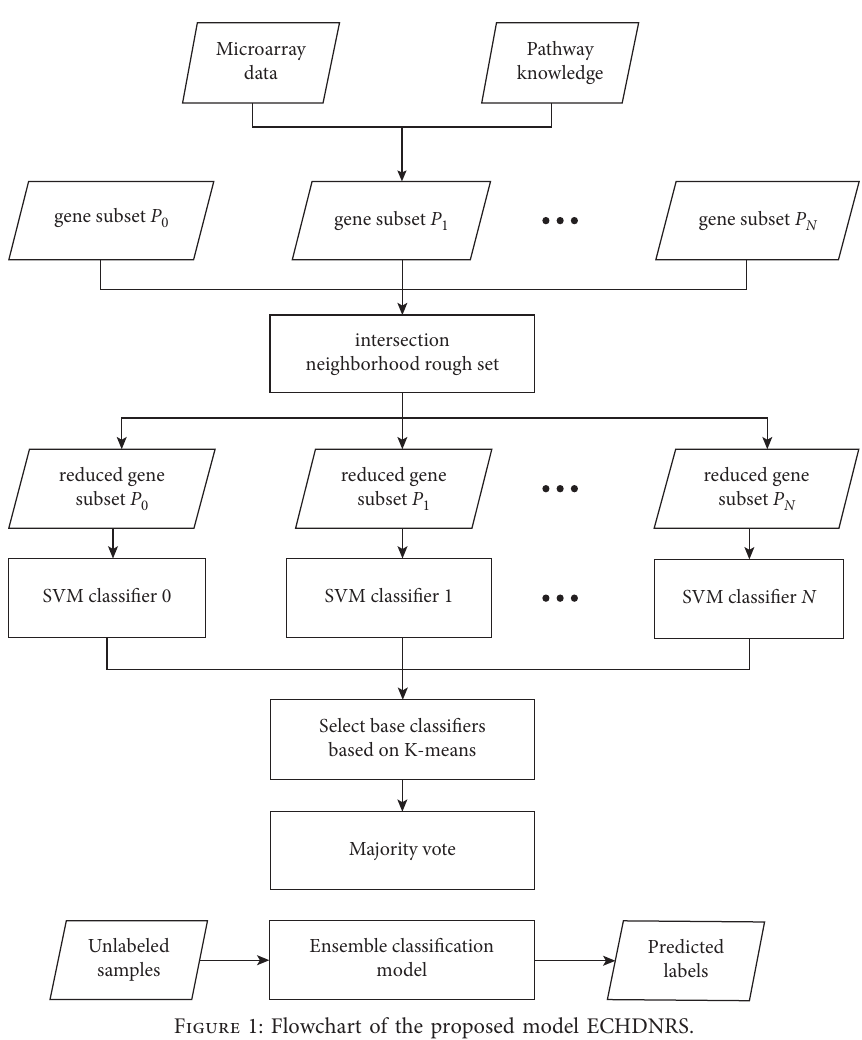
Figure 1: Flowchart of the proposed model ECHDNRS.